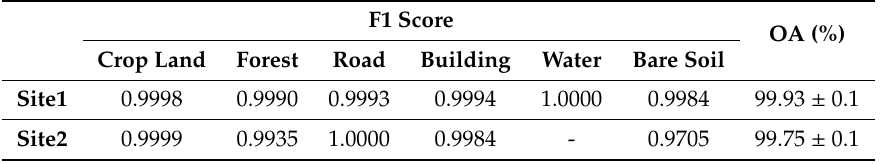
Table 2. Classification results of the South Korean sites: F1 score and overall